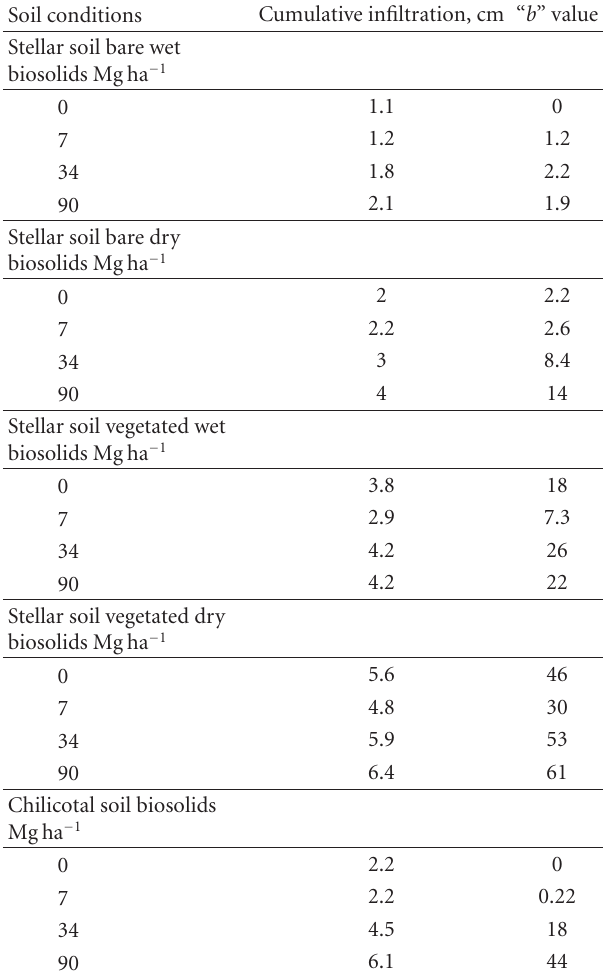
Table 1: Cumulative infiltration and Green Ampt “ b ” value for the Stellar soil under two wetness conditions and the Chilicotal soil on the Sierra Blanca